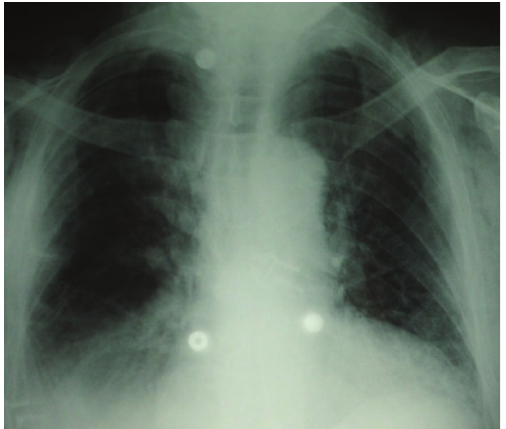
Figure 4: Postero anterior radiograph of the chest on Day